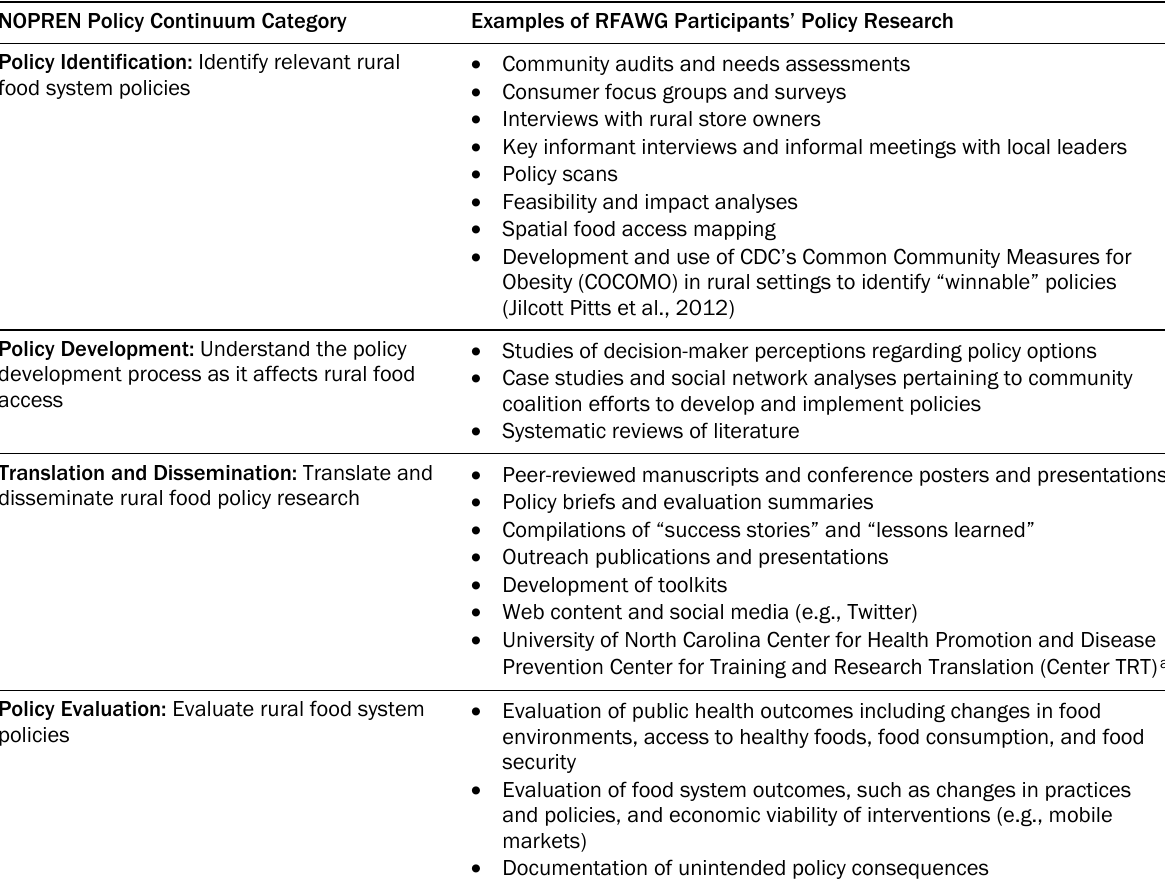
Table 2. Rural Food Access Working Group (RFAWG) Policy Research Across the Nutrition and Obesity Policy Research and Evaluation Network (NOPREN) Policy